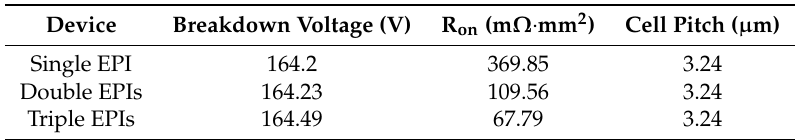
Figure 11. The output characteristic of the split-gate trench power MOSFET with single EPI, double EPIs, and triple EPIs. Table 5. The characteristic of single-EPI, double-EPIs, and triple-EPIs 150 V rating voltage split-gate trench power MOSFET at the same cell